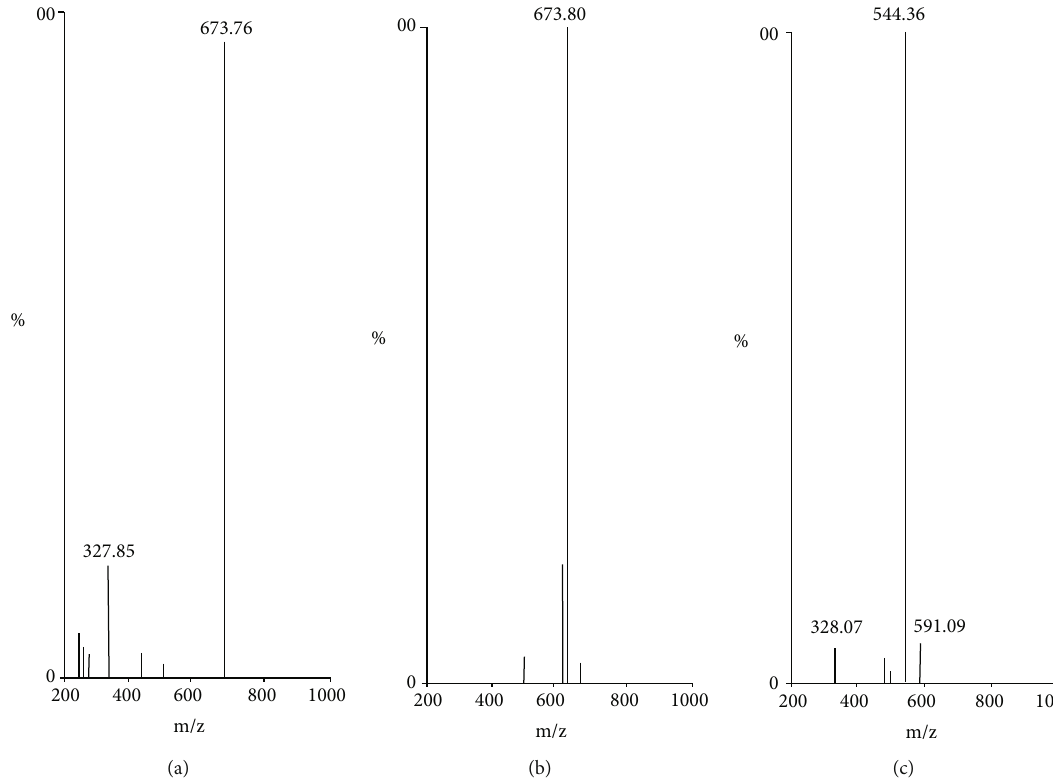
Figure 4: LC/ESI-MS spectra of the main peaks of crude peptides Gln-Asn-Cys-Pro-(D-Arg)-Gly cleaved from MBHAR (a), BUBHAR (b), and of the contaminant present in the peptide cleaved from MBHAR but lacking the Gln residue